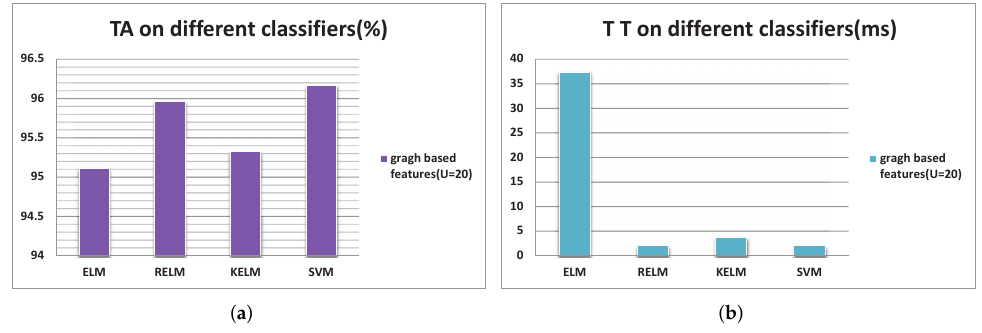
Figure 5. ( a ) TAs of the four different classifiers based on the same graph feature set and ( b ) TTs of the four different classifiers based on the same graph feature